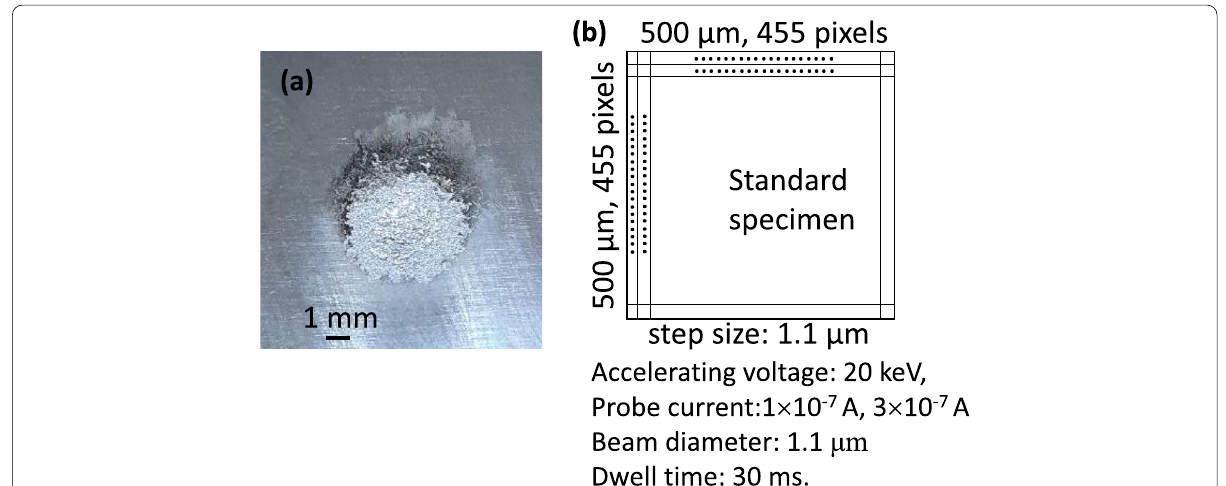
Fig. 2 Compositional inhomogeneities in the standard specimens; a C Kα (SRM 1767), b Mn Kα (SRM 1761), and c Si Kα (SRMC 1151a) maps. The maps were obtained under 20 keV(Accelerating voltage) and 3